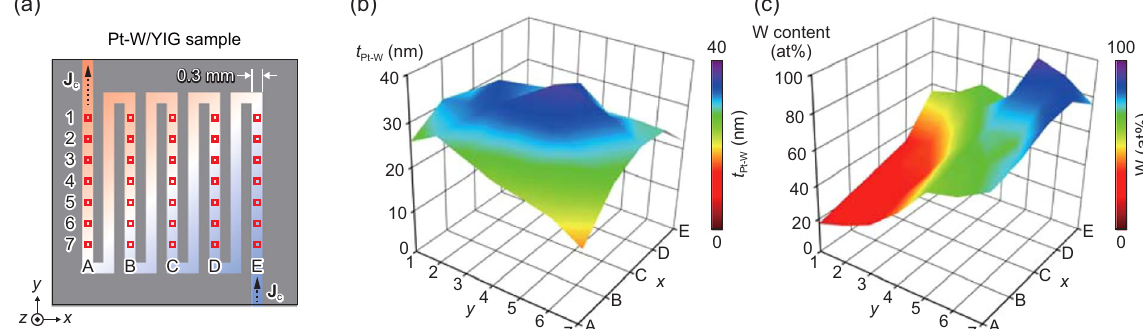
Figure 2. Thickness and composition distributions. ( a ) Schematic illustration of the Pt-W/YIG sample from a top view and definition of the areas A1-E7 on the meandered structure. ( b , c ) Distributions of the thickness t Pt-W ( b ) and W content ( c ) of the composition-spread Pt-W film (see Methods for